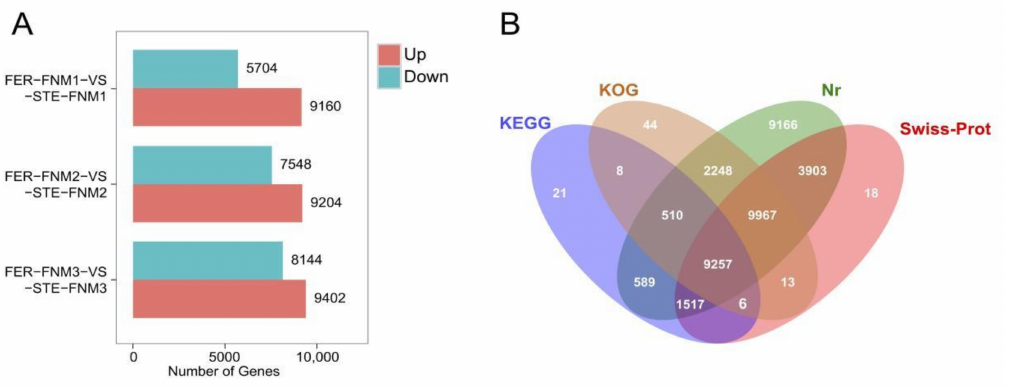
Figure 2. RNA sequencing data from ovules in P. tabuliformis . ( A ) Differentially expressed genes between FER and STE in FNM1, FNM2, and FNM3. ( B ) Venn diagram of unigene annotation in P. tabuliformis